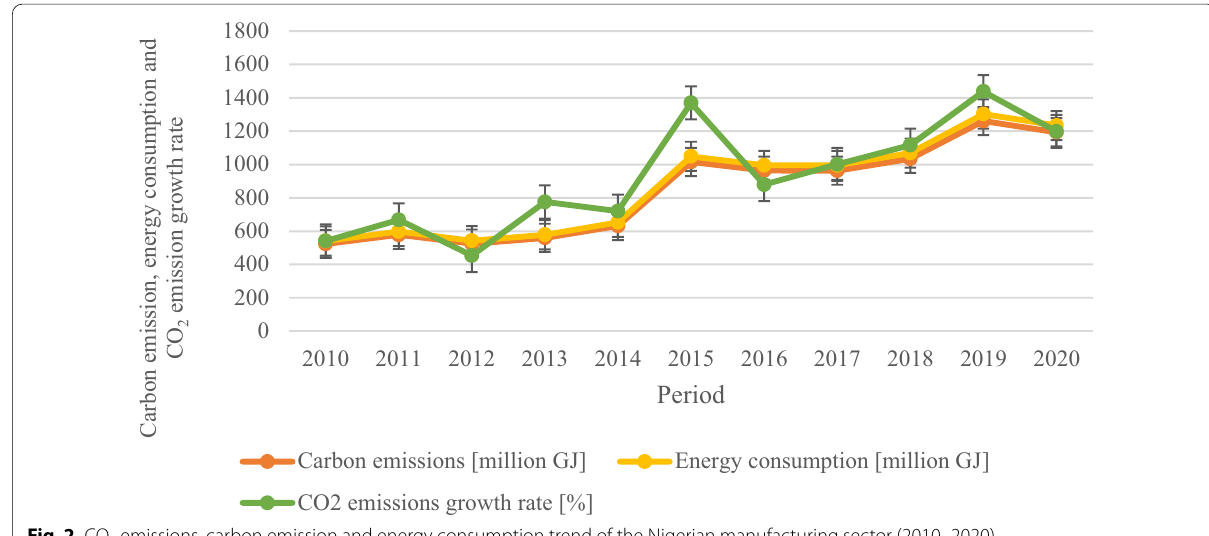
Fig. 2 CO 2 emissions, carbon emission and energy consumption trend of the Nigerian manufacturing sector (2010–2020)